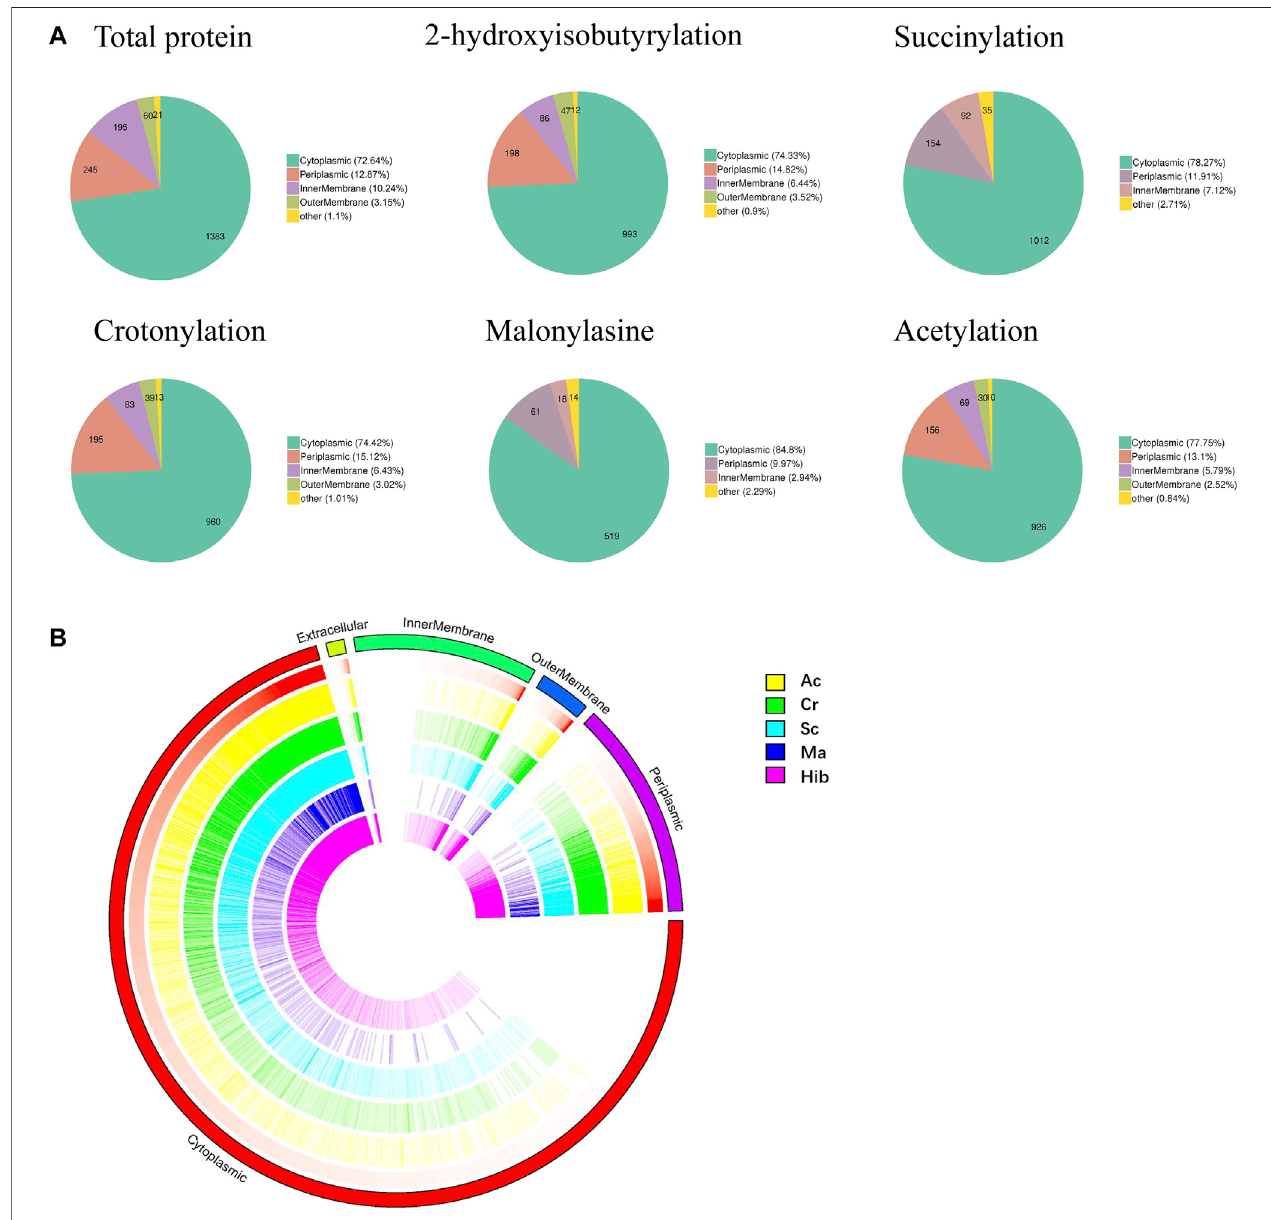
FIGURE 3 | Subcellular localization analysis of lysine modi fi ed proteins. Pie charts showing subcellular localization of each type of PTM, more than 70% proteins located in cytoplasmic (A) . Visual presentation of lysine modi fi ed proteins based on subcellular location in B. abortus 2308 (B) . The outermost circle of the circos plot means different subcellular localization, cytoplasmic (red), periplasmic (purple), outer membrane (dark blue), inner membrane (green), and extracellular (dull yellow). Five circles from the outside represents different modi fi ed sites (Hib, Cr, Sc, Ma and Ac), respectively. A deeper color represents higher enrichment of the modi fi cation. Note that the height of each bar re fl ects the subcellular organelle abundance of each protein or PTM site, i.e., longer bars represent a greater degree of abundance.